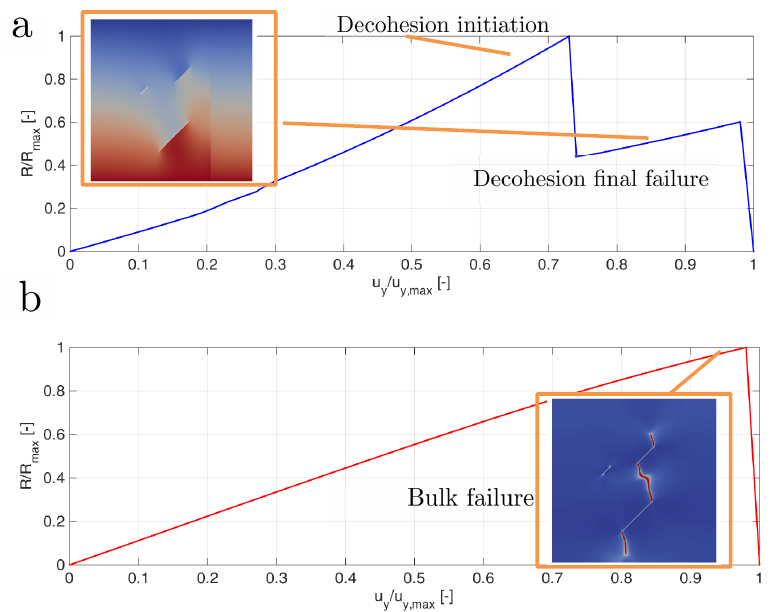
Figure 19. Specimen with 3 inclined flaws and a vertical interface: ( a ) Load-displacement curve for ¯ u y = − 0.1 ¯ u x . ( b ) Load-displacement curve for ¯ u y = − ¯ u x